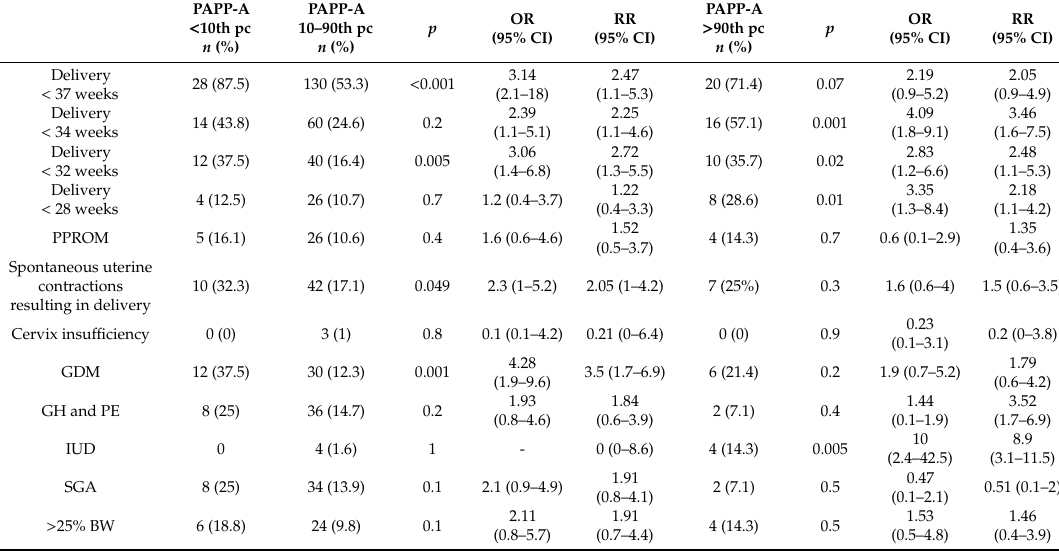
Table 2. Relationships between study outcomes and pregnancy associated plasma protein (PAPP-A) concentrations.